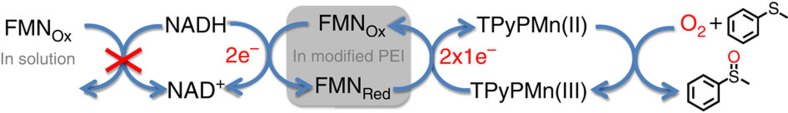
Schematic representation of the complete catalytic system.The artificial flavoenzyme collects electrons from NADH and provides a single-electron flow to the Mn(III) porphyrins to activate dioxygen and perform catalytic oxidation in water.